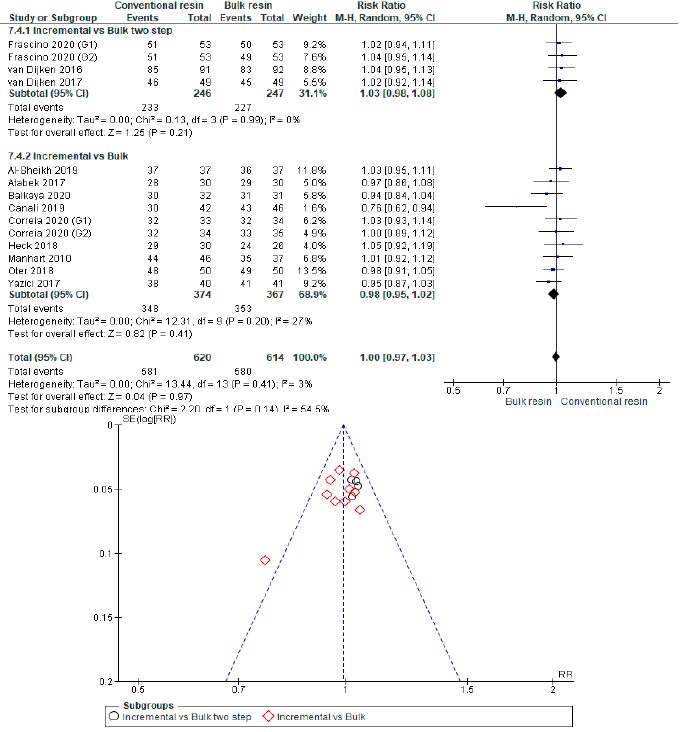
Figure A34. Proper Surface Texture: Conventional Resin versus Bulk Resin According to the Technique Used.